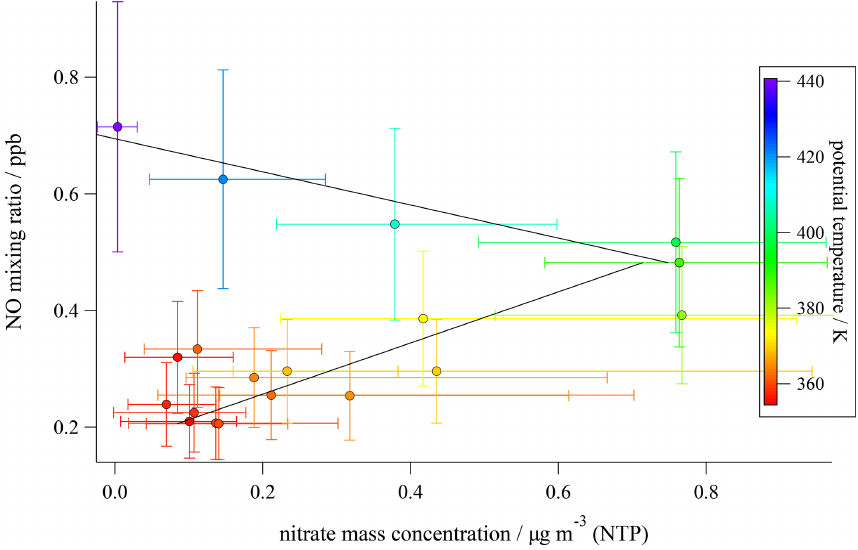
Figure 5. Nitrate mass concentration measured by the ERICA-AMS plotted against NO mixing ratio of SIOUX. The regression lines are shown to indicate the trends and are based on values for altitudes 10–17 and 17–19km, respectively. The horizontal bars reflect the 25th to 75th percentile range for nitrate and the vertical bars present an uncertainty of 30% for